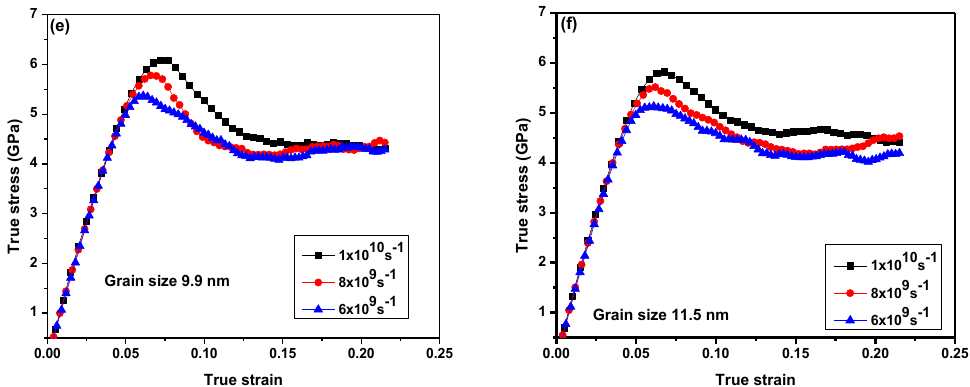
Figure 2. ( a – f ) True stress–strain curves for nanocrystalline (NC) 316 L stainless-steel with different mean grain sizes and at different strain rates (6 × 10 9 s −1 to 1 × 10 10 s −1 ).